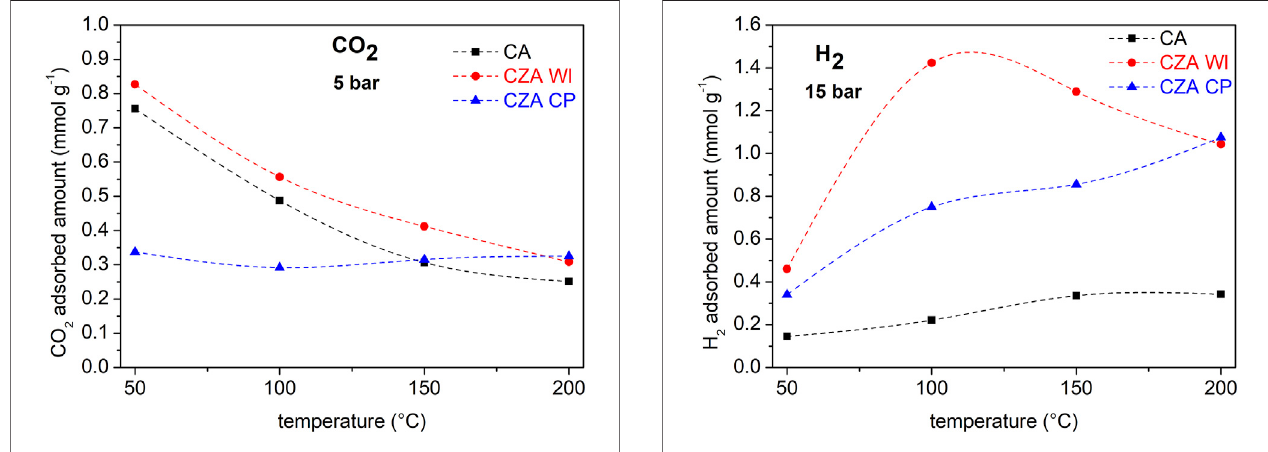
FIGURE 5 | CO 2 isobars on CA, CZAWI, and CZACP catalysts. FIGURE 6 | H 2 isobars on CA, CZAWI, and CZACP.